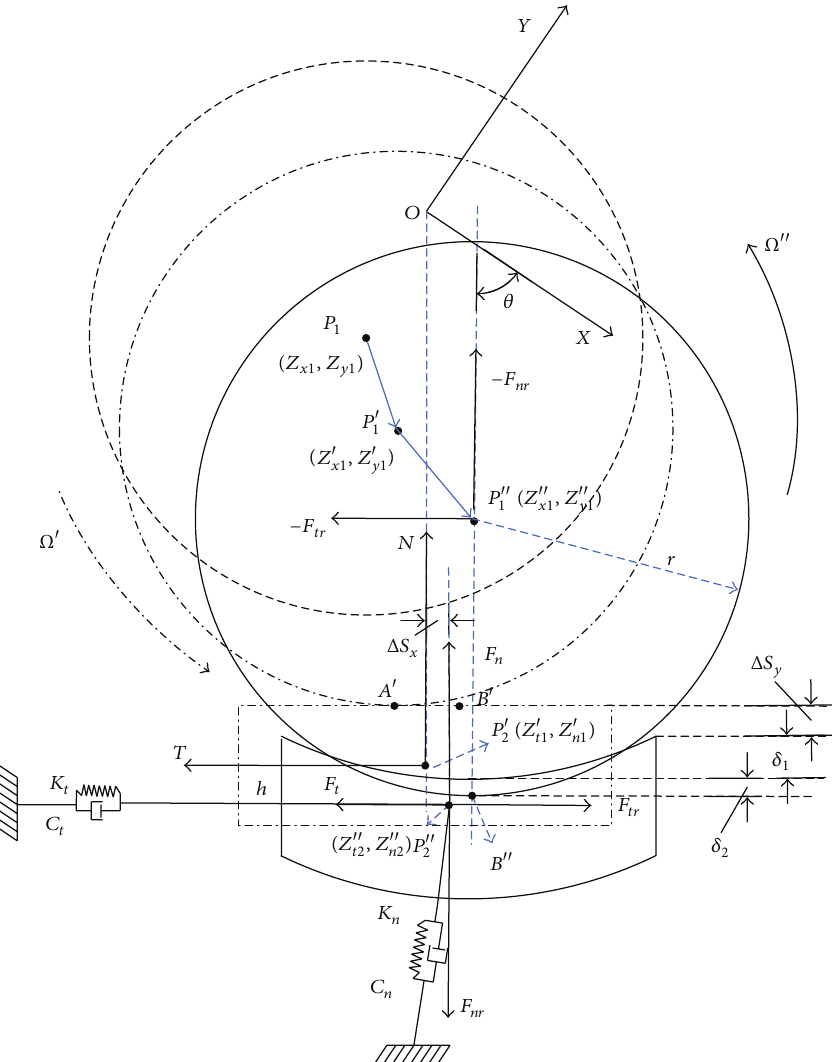
Figure 4: The dynamic model of rub-impact between rotor disk and elastic